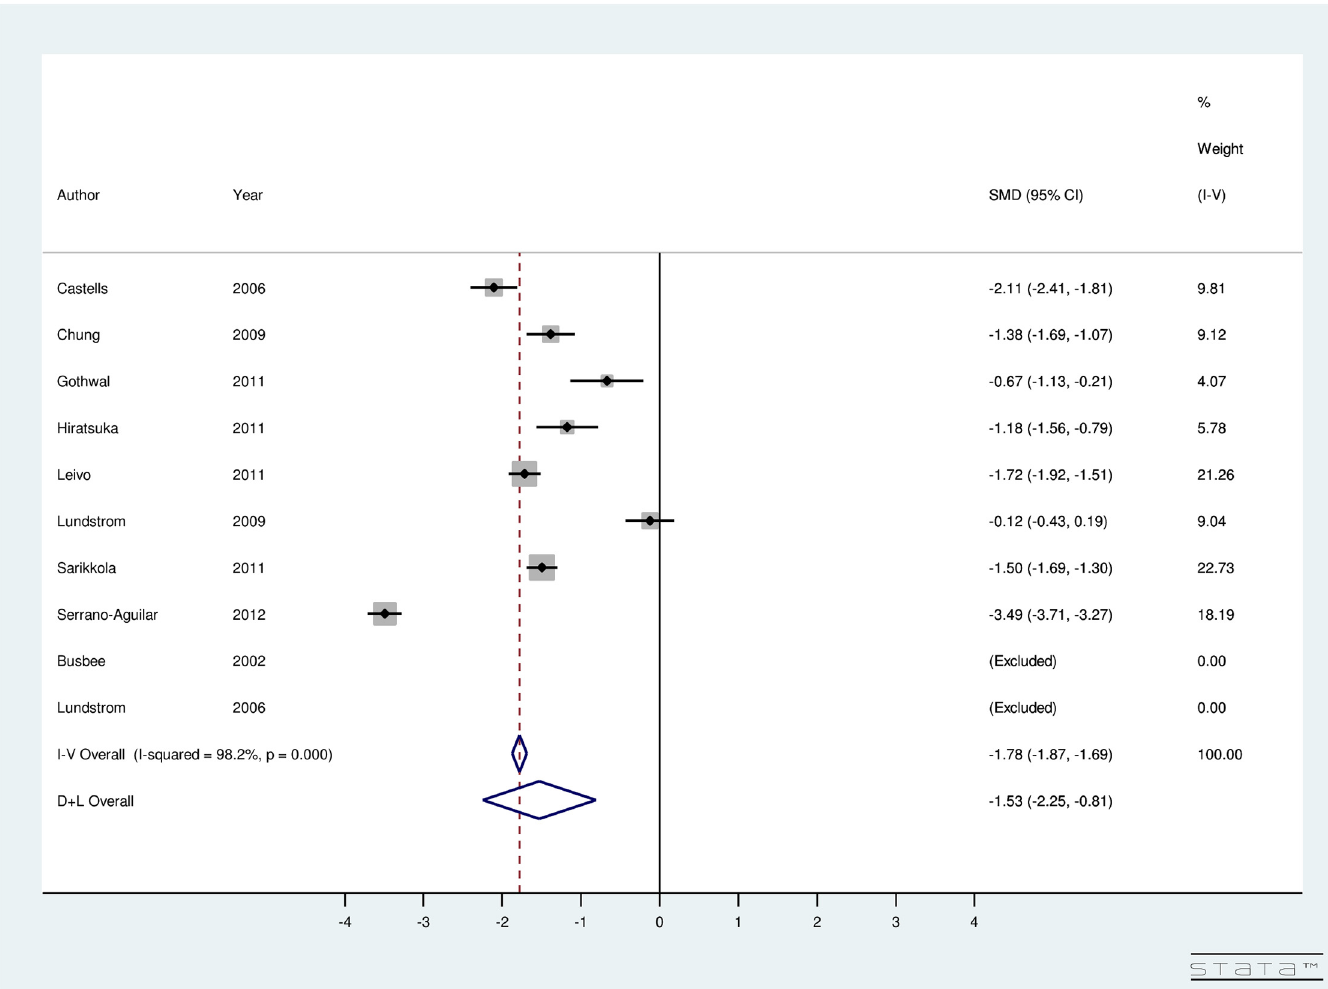
Fig 7. Forest Plot showing Improvement in Best Corrected Visual Acuity Due to Delayed Sequential Bilateral Cataract